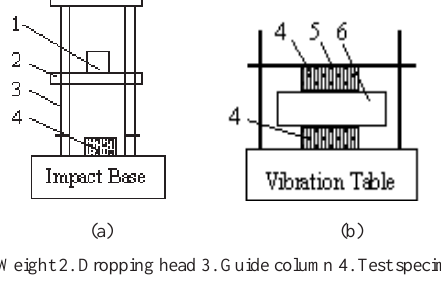
Fig. 2. The mount and fixture of test